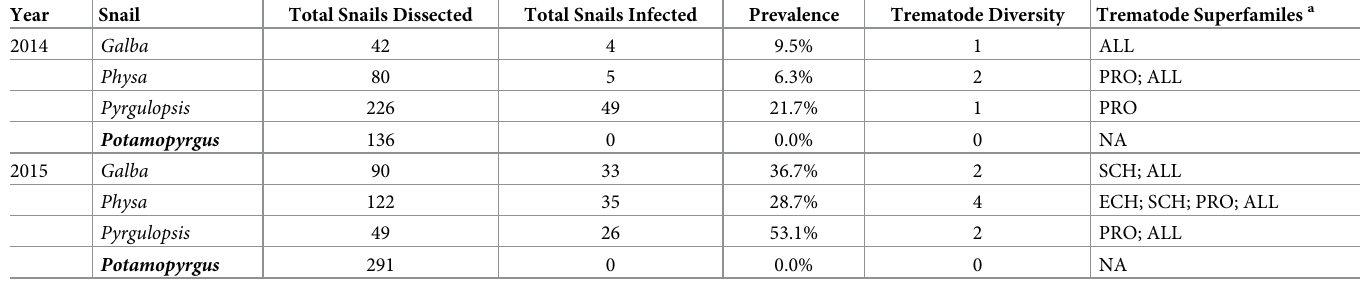
Table 1. Trematode infections at the field site. Trematode diversity, cercarial types, and prevalence of infection in snails from a field survey in Polecat Creek during July 2014 and 2015. The snail Potamopyrgus antipodarum is the only non-native snail in this ecosystem (shown in bold).